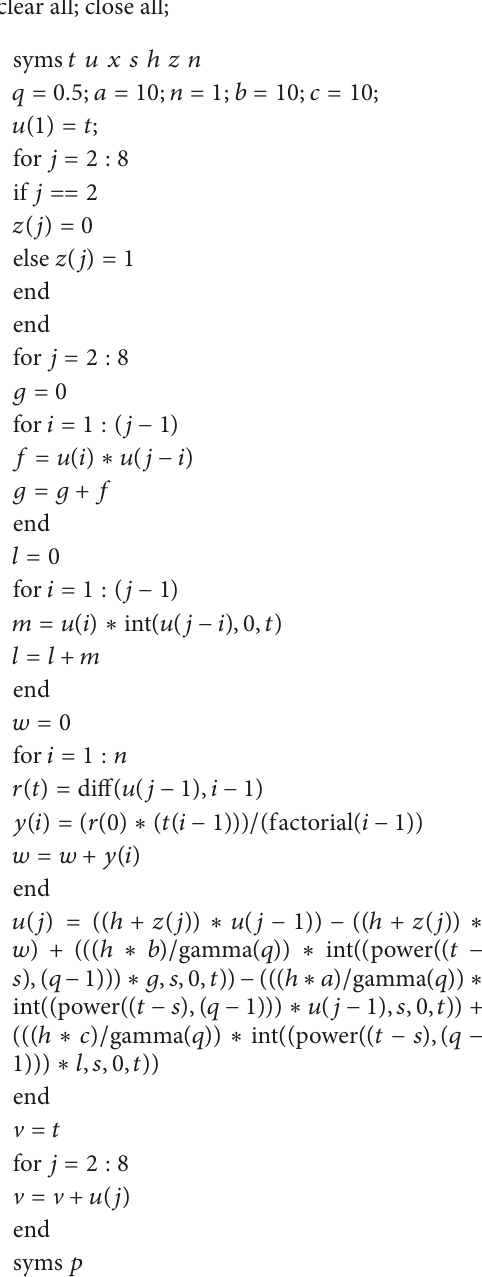
MATLAB code for Figure